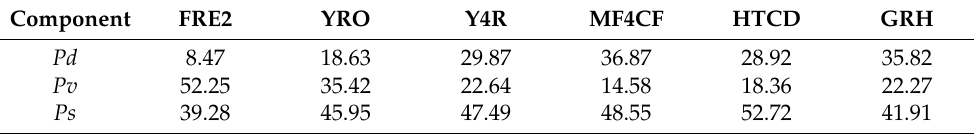
Table 2. The percentage of every polarization decomposition component for each algorithm (%). Component